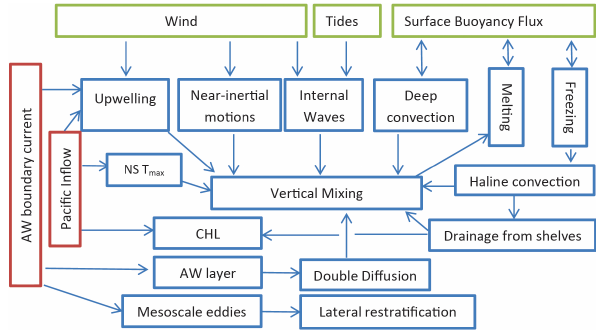
Figure 11. Main forcing (green), oceanic heat input (red), physical processes (blue), and their relations (arrows) in the Arctic Ocean. CHL is the cold halocline layer; AW is the Atlantic Water; and NS T max is the near-surface temperature